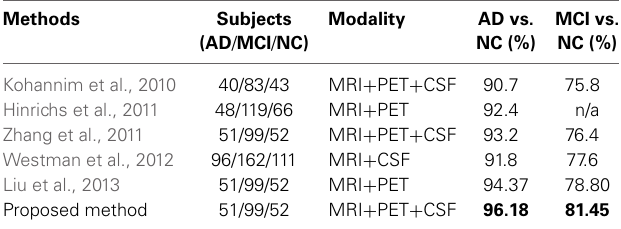
Frontiers in Aging